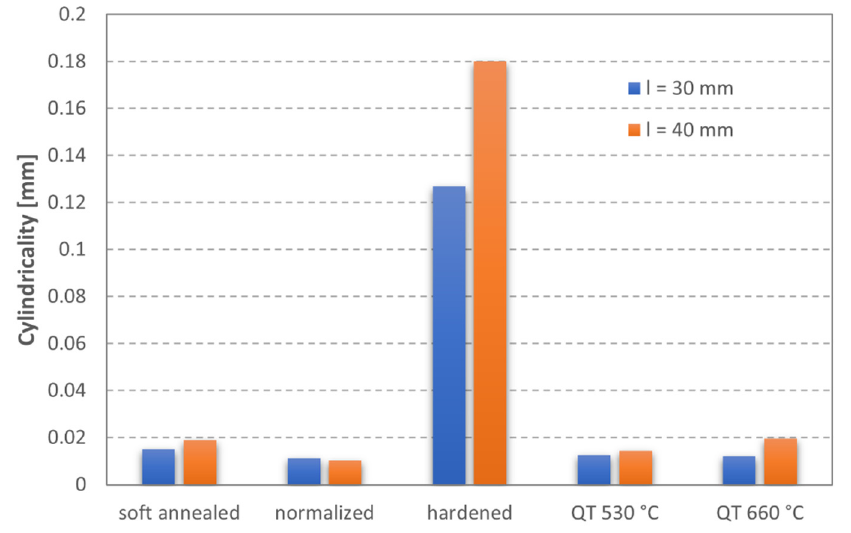
Figure 6. Cylindricity of machined surfaces.